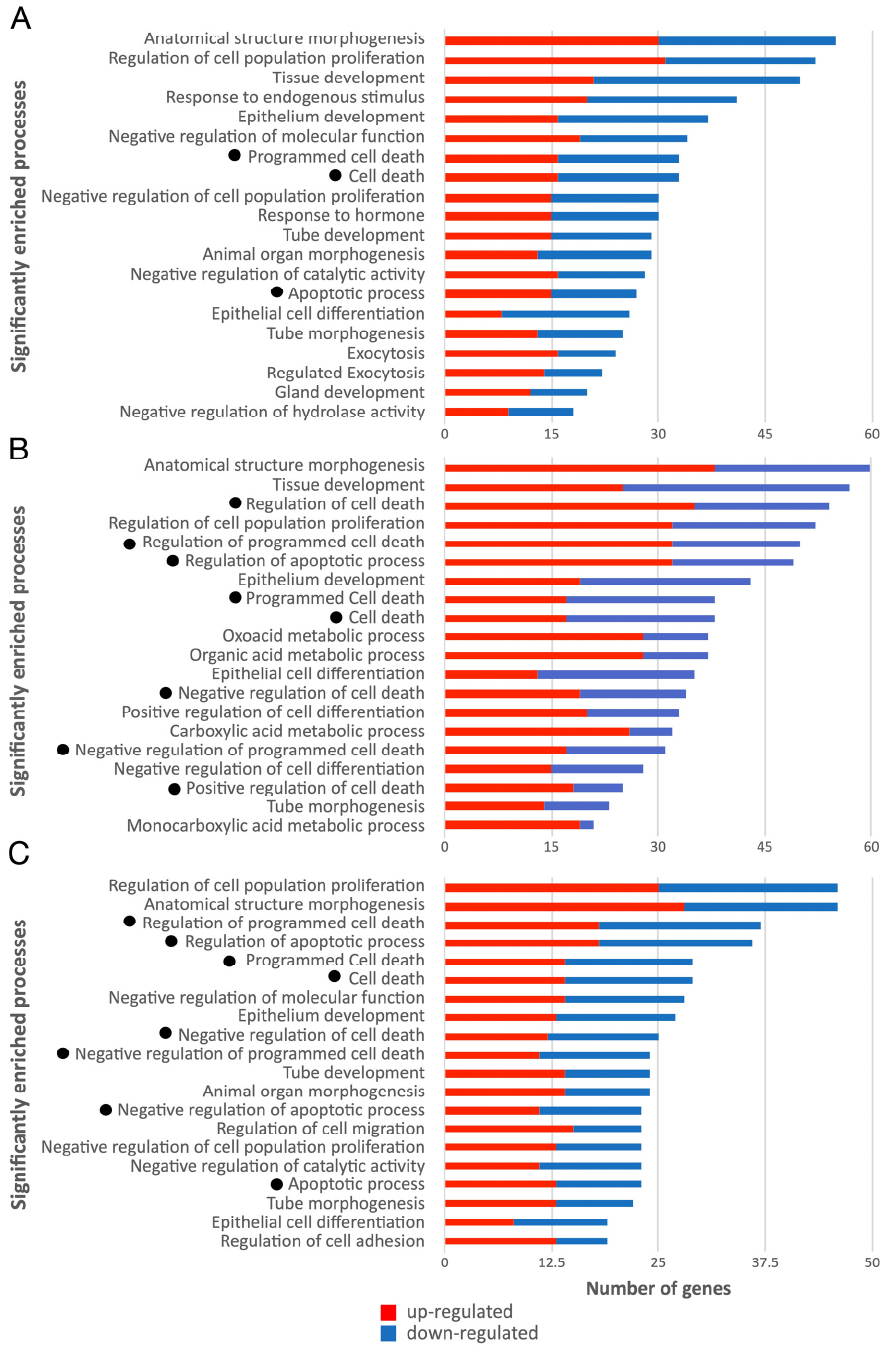
Figure 7. Enrichment analysis of biological processes related to genes regulated by OHT in com- bination with ATRA. Statistically significantly enriched biological processes based on Gene Ontol- ogy enrichment analysis, with the number of corresponding genes, upon treatment of MCF7-WT significantly differentially expressed genes involved in each process is shown on the X axis, with red and blue colors corresponding to up- or downregulation, respectively. Cell-death-related processes are indicated with dots. OHT, 4-hydroxytamoxifen; ATRA, all-trans retinoic